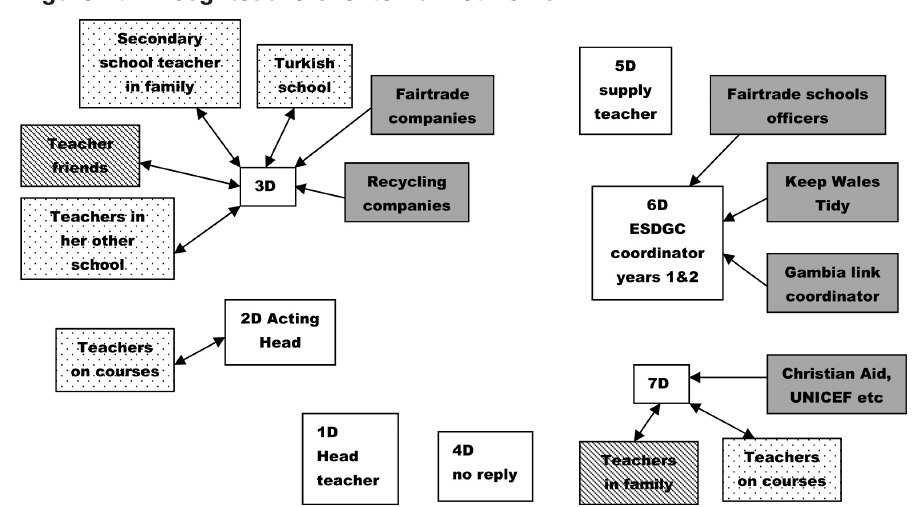
Figure 1d: Drosgl teachers’ external